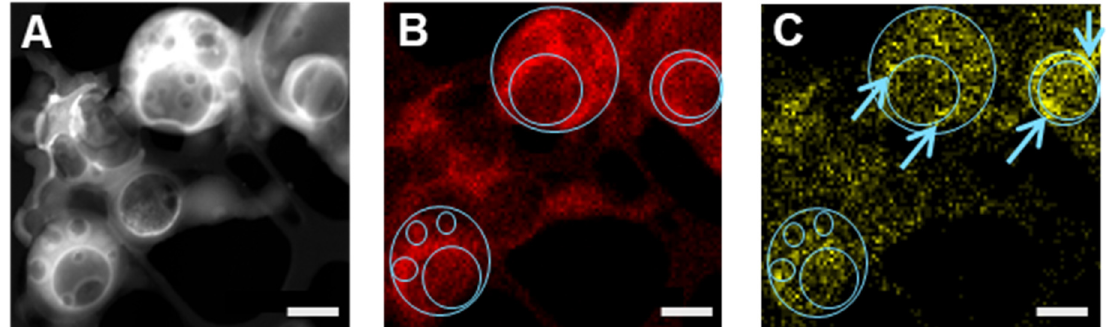
Figure 8. ( A ) STEM image of VCM-loaded PLGA 15 C NPs in which inner aqueous compartments are visible. Chemical mapping for elemental analysis of ( B ) carbon (red) and ( C ) nitrogen (yellow). Blue lines are guides for the eyes and blue arrow indicates nitrogen-rich regions. Scale bars are 500 nm.